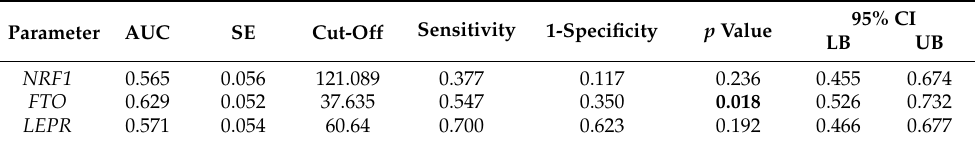
Table 8. ROC curve analysis of methylation of NRF1, FTO, and LEPR with the BMI category shows the relationship between sensitivity and specificity in determining a specific marker.